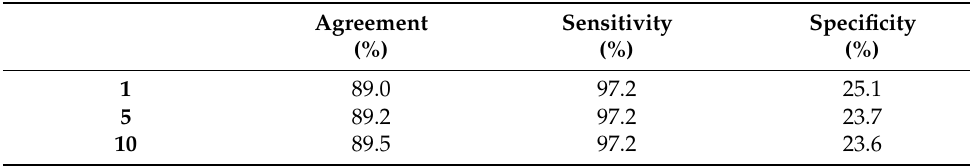
Table 2. Epoch-by-epoch agreement, sensitivity, and specificity.